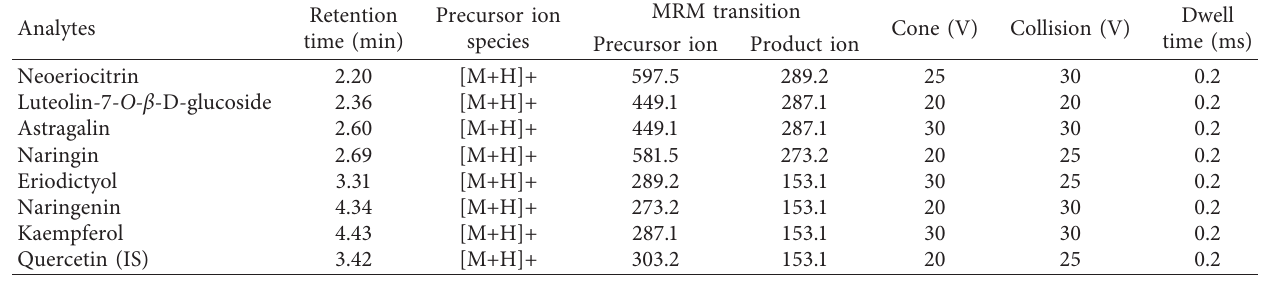
Table 1: Precursor ion and product ion transition and parameters of the analytes used in this